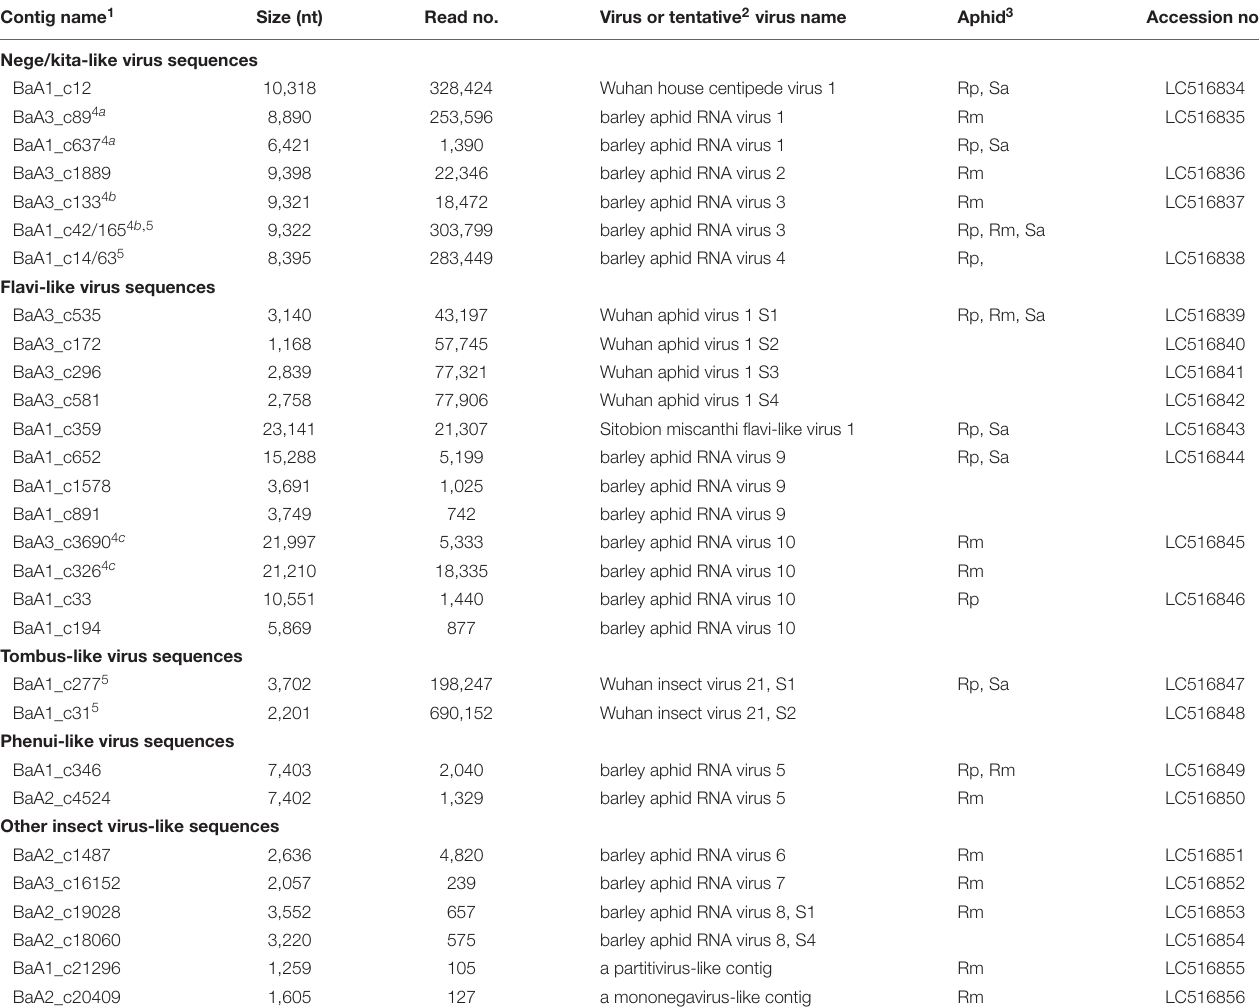
TABLE 2 | Major virus-like sequences from the barley aphid